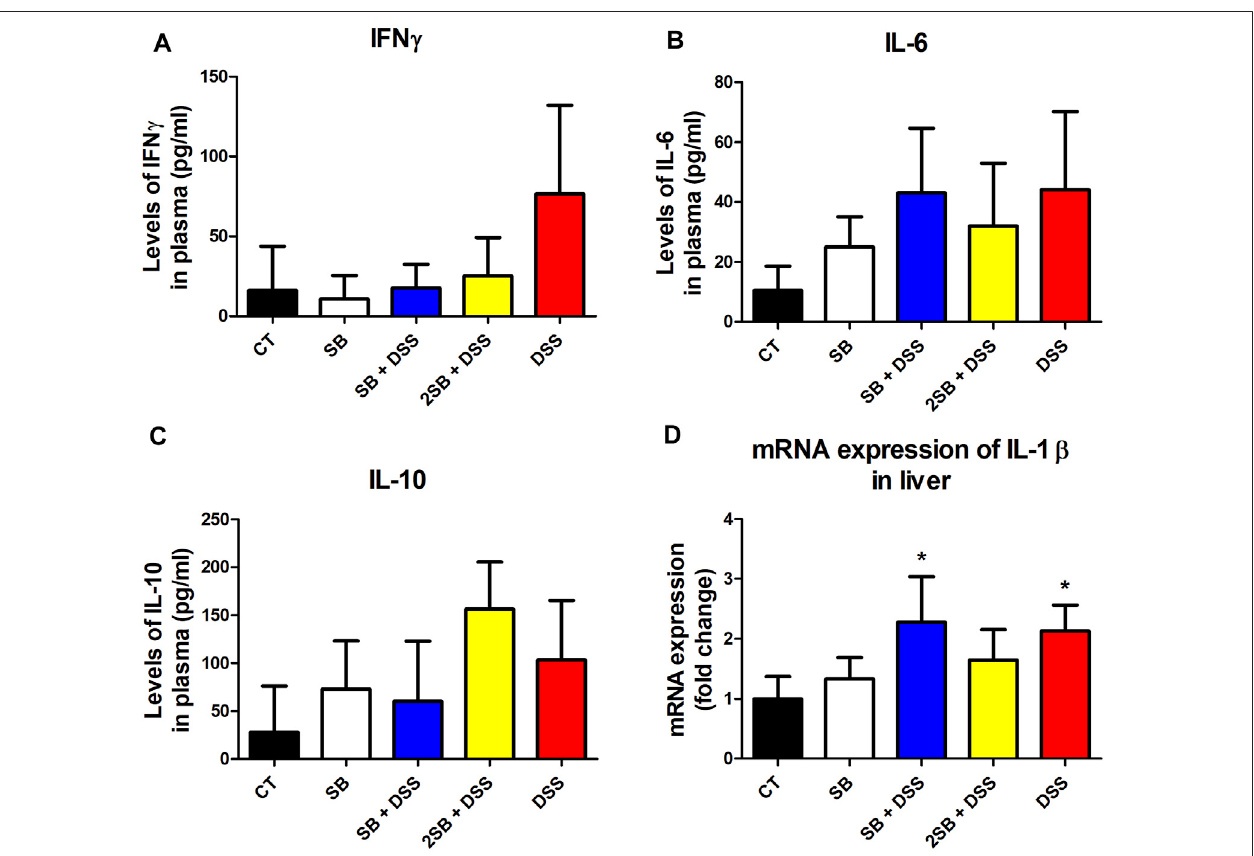
FIGURE3| Sodium butyrate administration in fl uence thelevel ofDSS-inducedcytokine response in plasma and liverofexperimental mice. (A) IFN- γ , (B) IL-6, and (C) IL-10 cytokine levelswere measured byELISAinplasmaofexperimental miceand areexpressed aspg/ml. (D) Quantitative PCRanalysisofmRNAexpression ofIL- 1 β wasperformedintheliverofmice.Valuesareexpressedasmean±SD( n =5)andrepresentoneoutoftwoexperiments.One-wayANOVAwithTukey ’ smultiple post hoc test wasused for comparison ofexperimental groups toCTcontrols (group 1: * p < 0.05). CT : drinking waterfor 1week; SB :0.5% sodium butyratein drinking water for 2 weeks; SB + DSS : 0.5% sodium butyrate in drinking water 1 week before and the next week together with 2.5% DSS in drinking water; 2SB + DSS : 0.5% sodium butyrate in drinking water 2 weeks before 2.5% DSS treatment in drinking water; DSS : 1 week 2.5% DSS in drinking water.